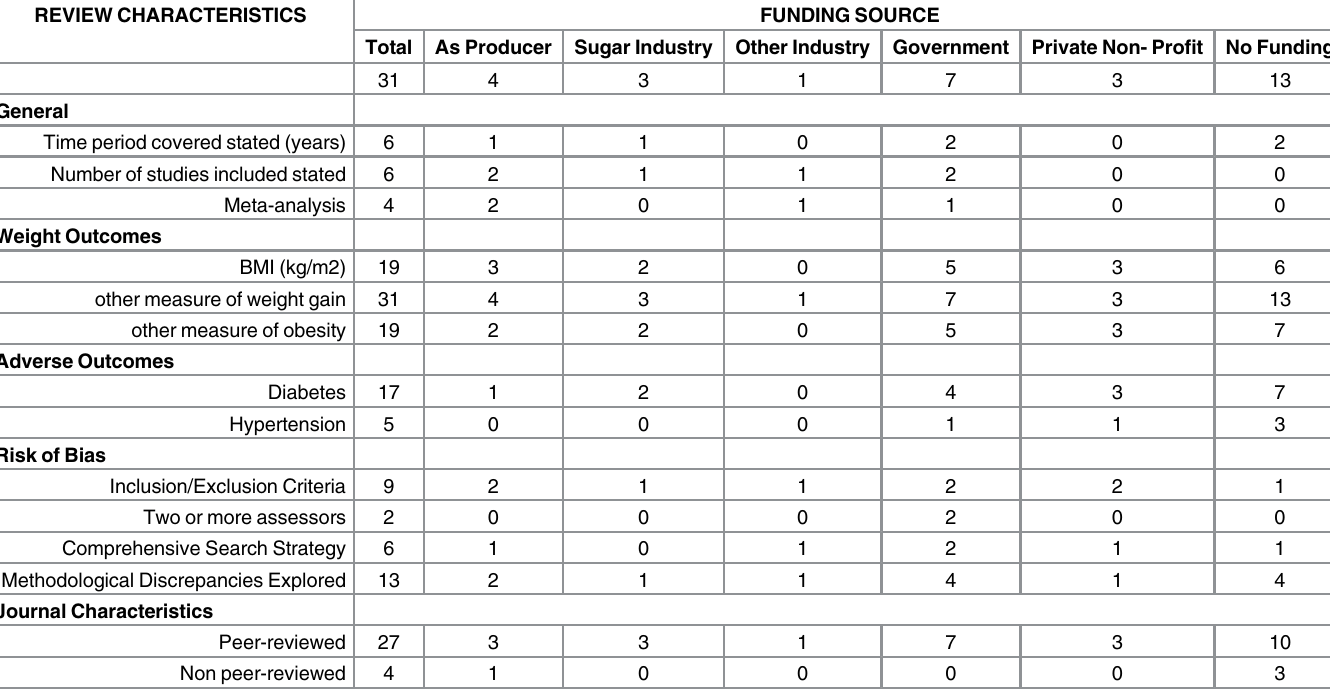
Table 1. Review characteristics and risk of bias by funding source (n = 31).